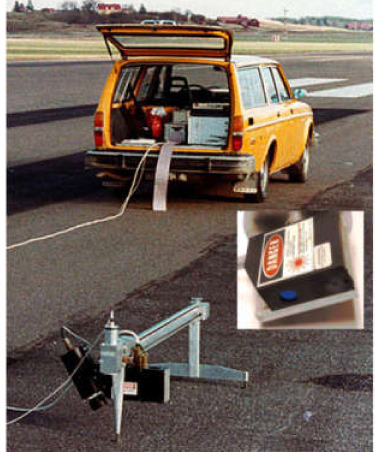
Figure 1. The VTI stationary profilometer, with its “macro” sensor mounted on the sled, and the “micro” sensor inserted in the photo, resized to approximately 5 times the scale of the rest of the photo. The photo was shot in another